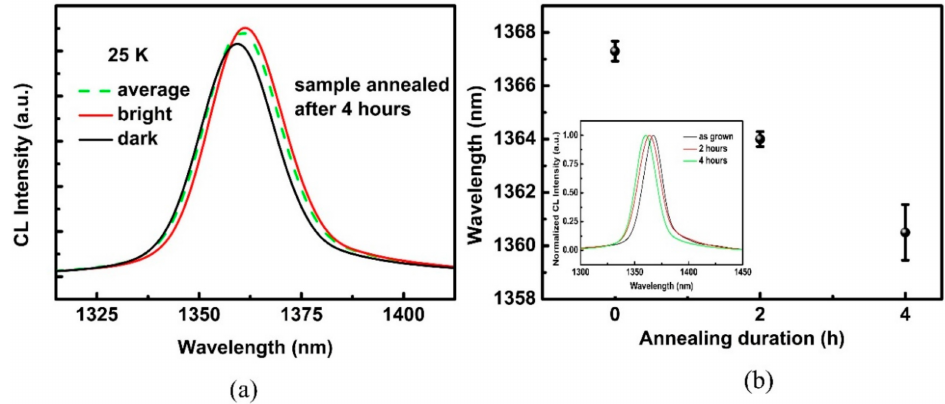
Figure 6. ( a ) Most probable emission CL spectra in the mapping (dashed line) and spatially resolved cathodoluminescence (SRCL) spectra with maximum and minimum emission energy (solid lines) for sample annealed after 4 h. ( b ) The SRCL distribution range for Al 0.07 Ga 0.22 In 0.71 As QW with different thermally treated durations. Inserted illustration shows the most probable emission CL spectrum of each sample.